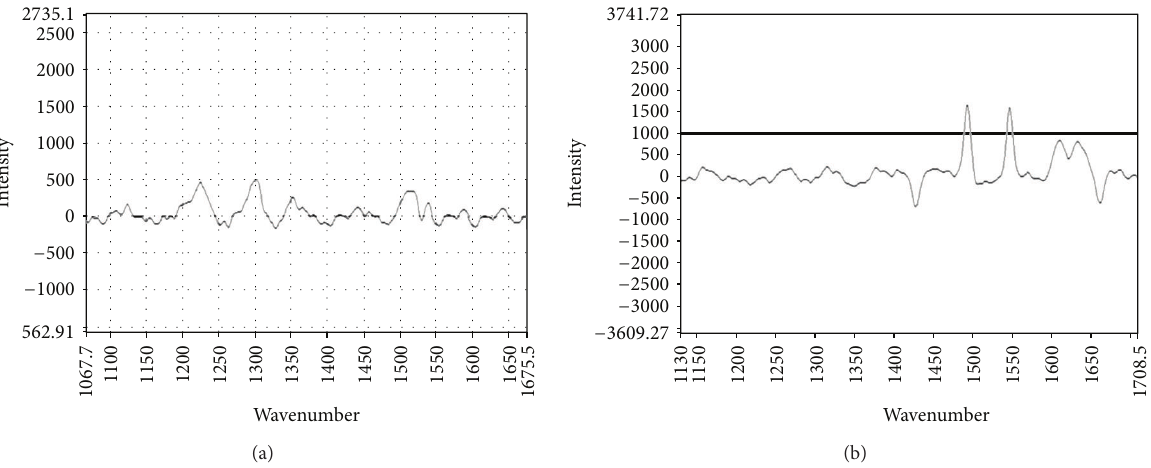
Figure 8: Raman spectrum of stability samples in alkali media (pH 7.2): control (Pure CUR) (a), SNP formulation (SP2) (b).